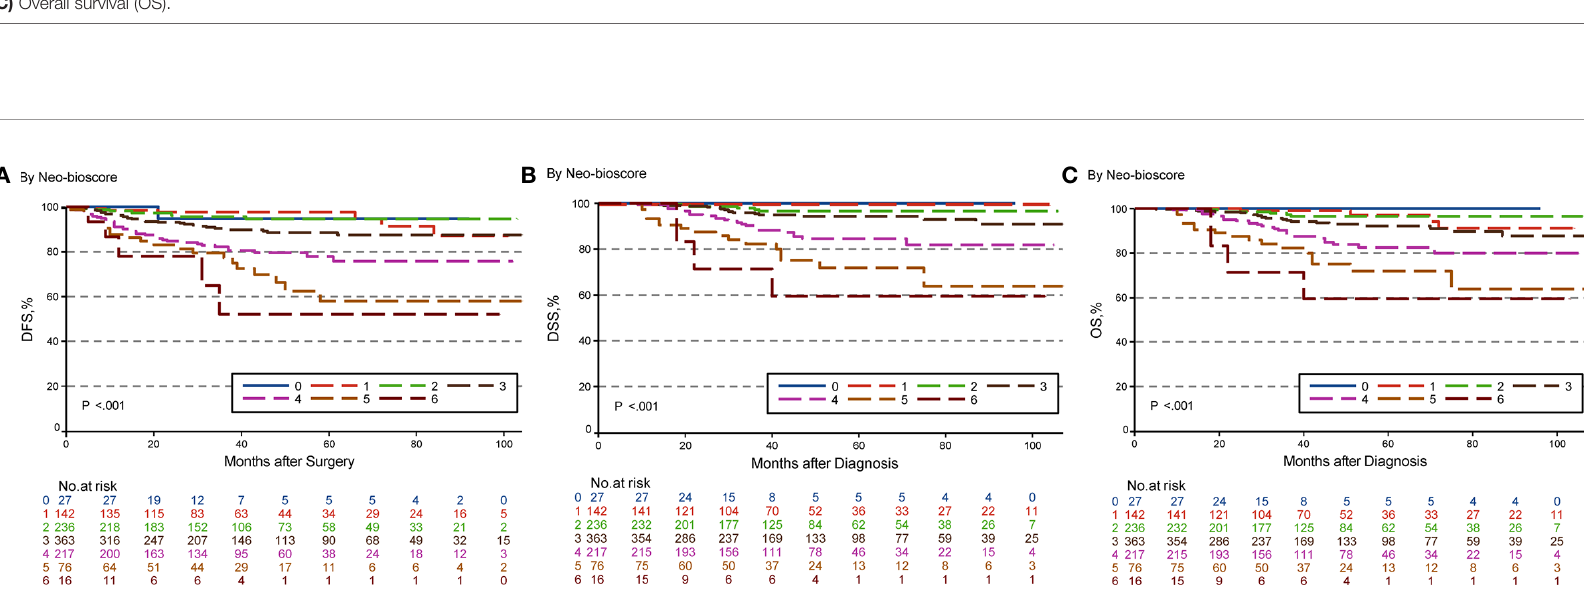
FIGURE 3 | Kaplan – Meier survival curves determined by Neo-Bioscore in patients with breast cancer receiving preoperative systemic therapy (PST). (A) Disease free survival (DFS); (B) Disease speci fi c survival (DSS); (C) Overall survival